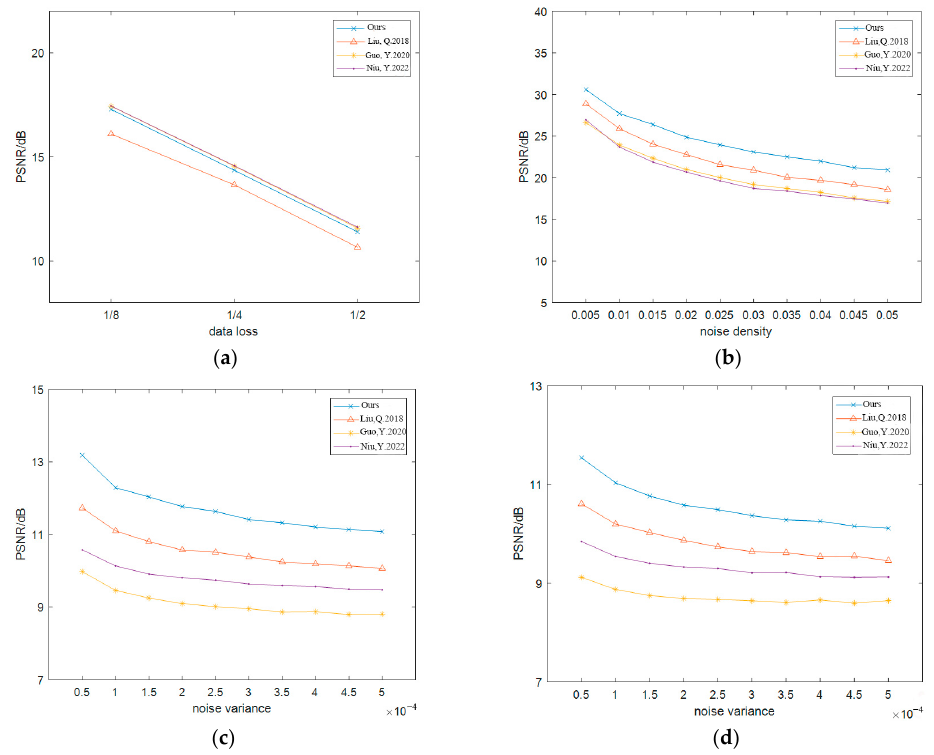
Figure 13. The PSNR test results of Lena ( a ) cropping attack; ( b ) SPN [4]; ( c ) SN [7]; ( d ) GN [8].